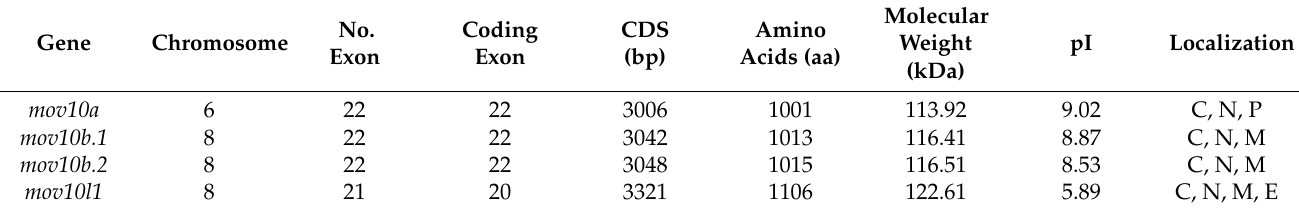
Table 1. Summary of the features of the mov10s and mov10l1 in